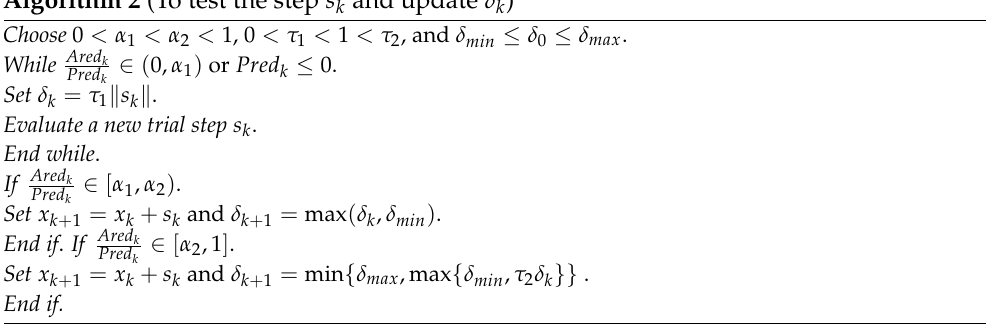
Algorithm 2 (To test the step s k and update δ k )